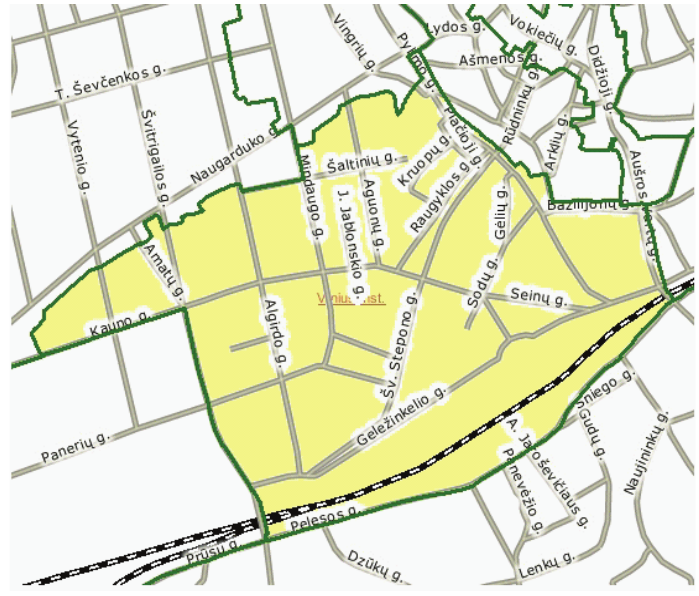
figure 3. the value zone 57.11, which includes the